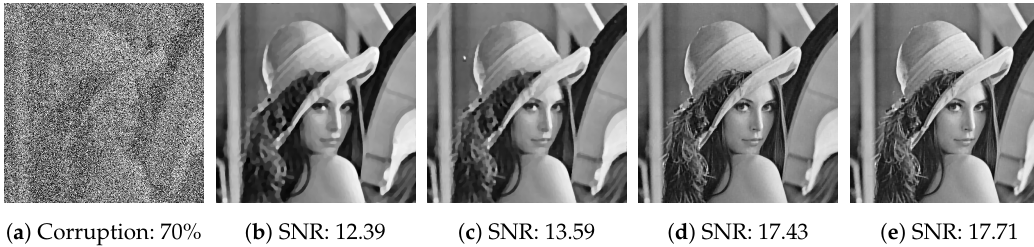
Figure 10. Comparisons of TVL1, HTVL1, CTVL1 and HOCTVL1 model on the Lena image corrupted by Gaussian blur and salt-and-pepper noise with noise level 70%. ( a ) Corrupted image. ( b ) TVL1 model. ( c ) HTVL1 model. ( d ) CTVL1 model. ( e ) HOCTVL1